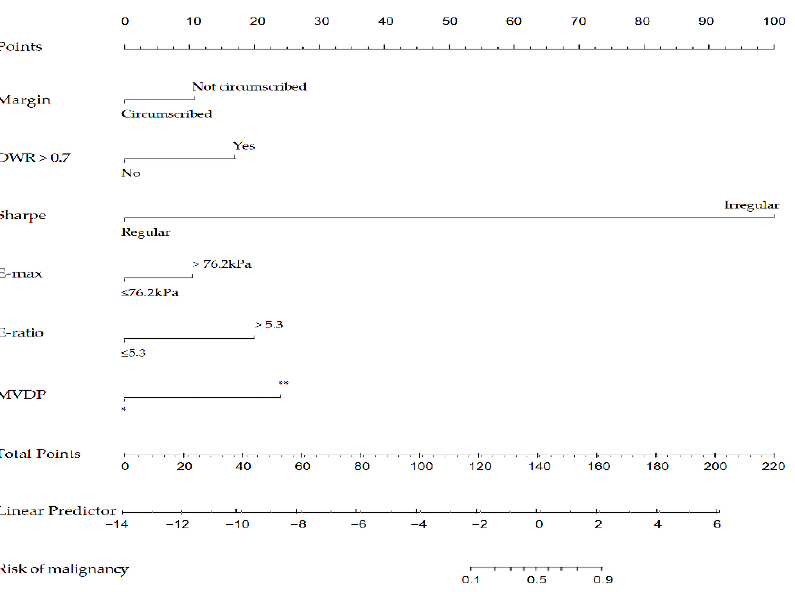
Figure 5. SWE, AP, and Conventional Ultrasound Imaging biomarkers’ selection using the least ab- solute shrinkage and selection operator (Lasso) algorithm. ( a ) The coefficient convergence graph for the feature selection process; ( b ) The ordinate is the binomial deviation, and the abscissa is log(λ).